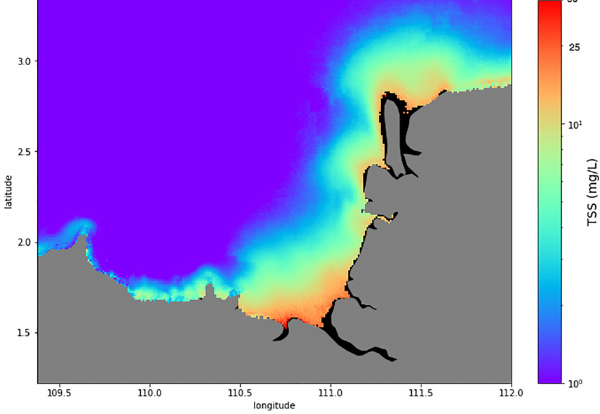
Figure 5. Map of the CV (%) calculated from the daily time series of MODIS Aqua satellite images from 2003 until